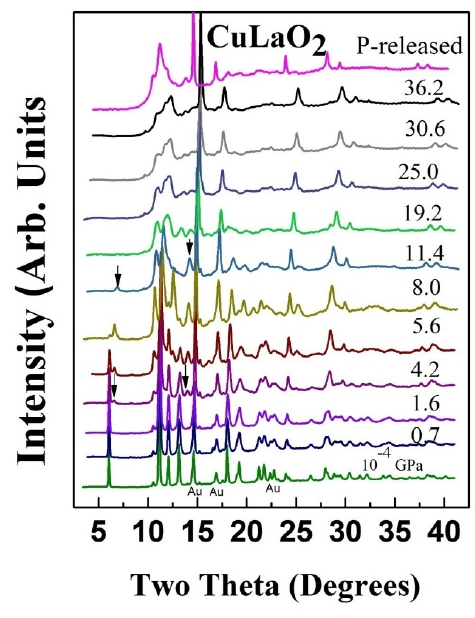
Figure 6. X-ray diffraction data for CuLaO 2 at a few selected pressures. Arrow indicates appearance of new peaks indicating instability in the ambient phase. Diffraction peaks from gold, used as insitupressure marker is indicated with Au.